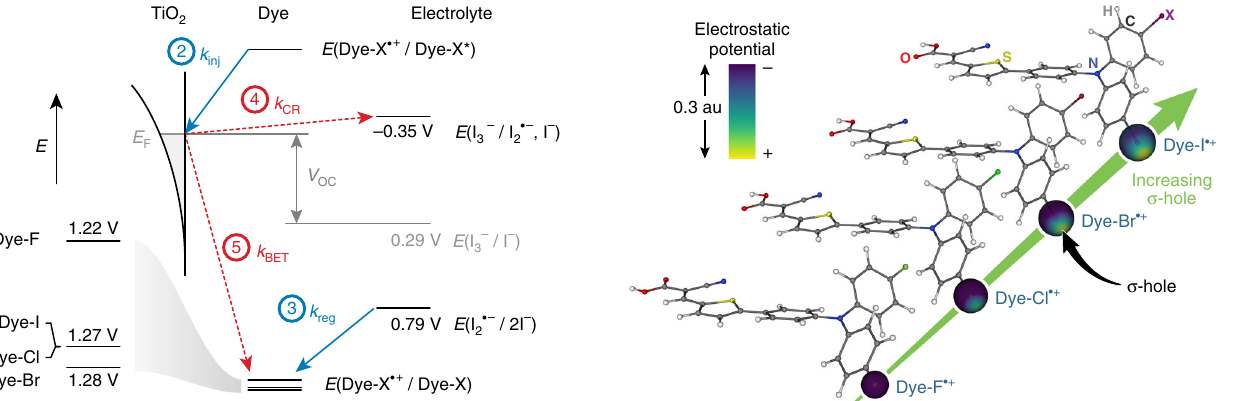
Fig. 5 Increasing σ -hole on Dye-X series. DFT models of the singly-oxidized dyes, Dye-X • + (where X is F, Cl, Br, and I), reveal an increasingly electropositive σ -hole on the terminus of the halogen substituents as the size of the halogen increases. The electrostatic potential is plotted over a sphere corresponding to the Van der Waals radius of the respective halogen